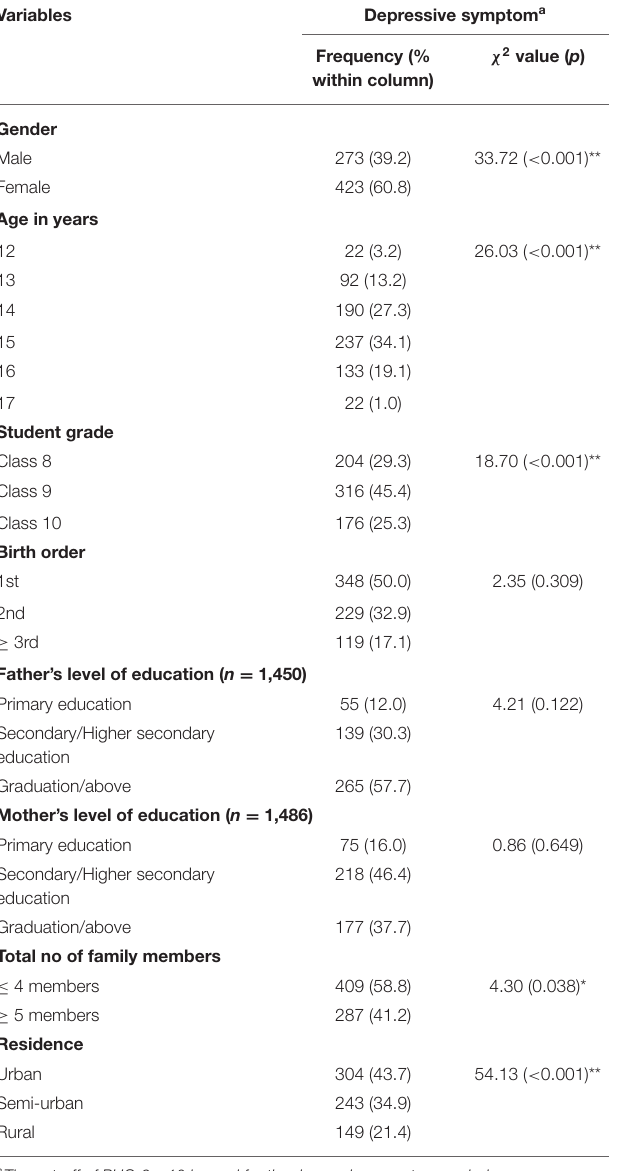
TABLE 2 | Association of lifestyle variables with students’ depressive